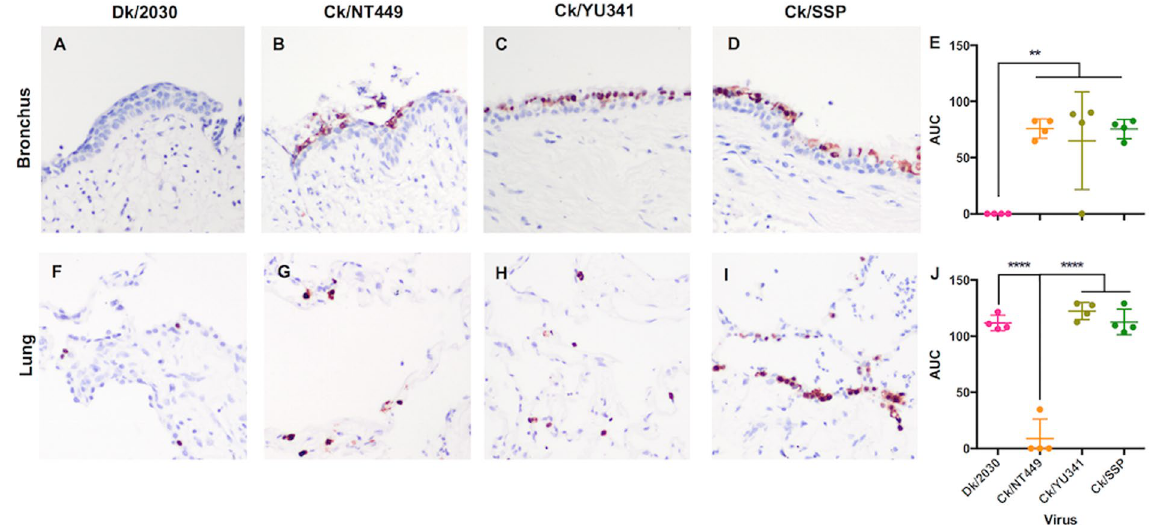
Figure 2. The cellular distribution of influenza nucleoprotein and the viral replication extensiveness in the human bronchus and lung after the infection with avian H9 viruses. The cellular localization of viral antigen in ( A to D ) bronchi, and ( F to I ) lung infected with avian ( A and F ) A/Duck/ST/2030/2001 (H9N1), ( B and G ) A/ Chicken/HK/NT449/2007 (H9N2), ( C and H ) A/Chicken/HK/YU341/2008 (H9N2) and ( D and I ) A/Chicken/ HK/SSP117W/2009 (H9N2) viruses at 24hpi were shown. The chart showed the mean and the SD of the AUC values of each virus pooled from at least three independent experiments ( E ) in the bronchus and ( J ) in the lung cultures were shown. ** p < 0.01, **** p <